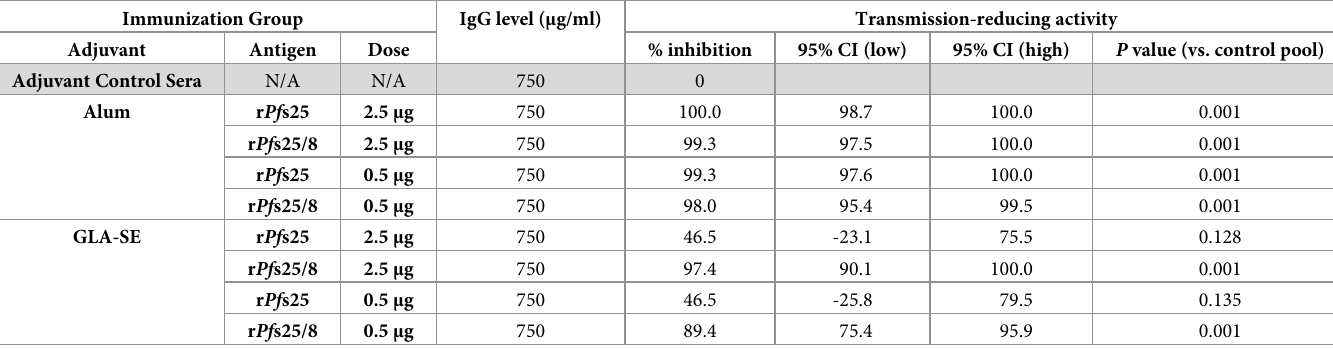
Table 1. Transmission-reducing activity of vaccine-induced IgG is a function of antigen and adjuvant. Immunization